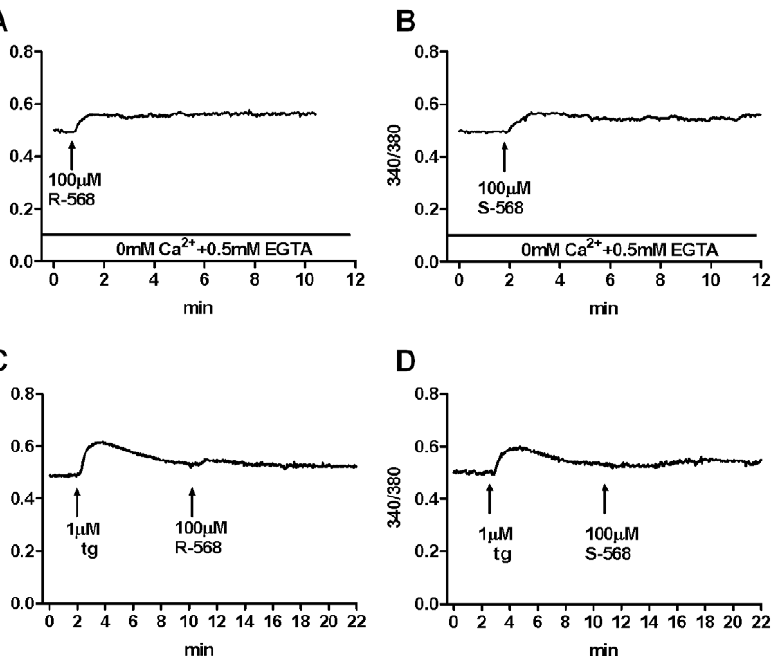
Figure 3. Effects of R-568 or S-568 on HUVECs [Ca 2 + ] i without extra or intracellular Ca 2 + . Representative Ca 2 + -variations in FURA-2AM- loaded HUVECs stimulated with 100 m M R-568 or 100 m M S-568 in Ca 2 + free medium (A and B) or after depletion of intracellular Ca 2 + stores by thapsigargin (tg) (C and D).